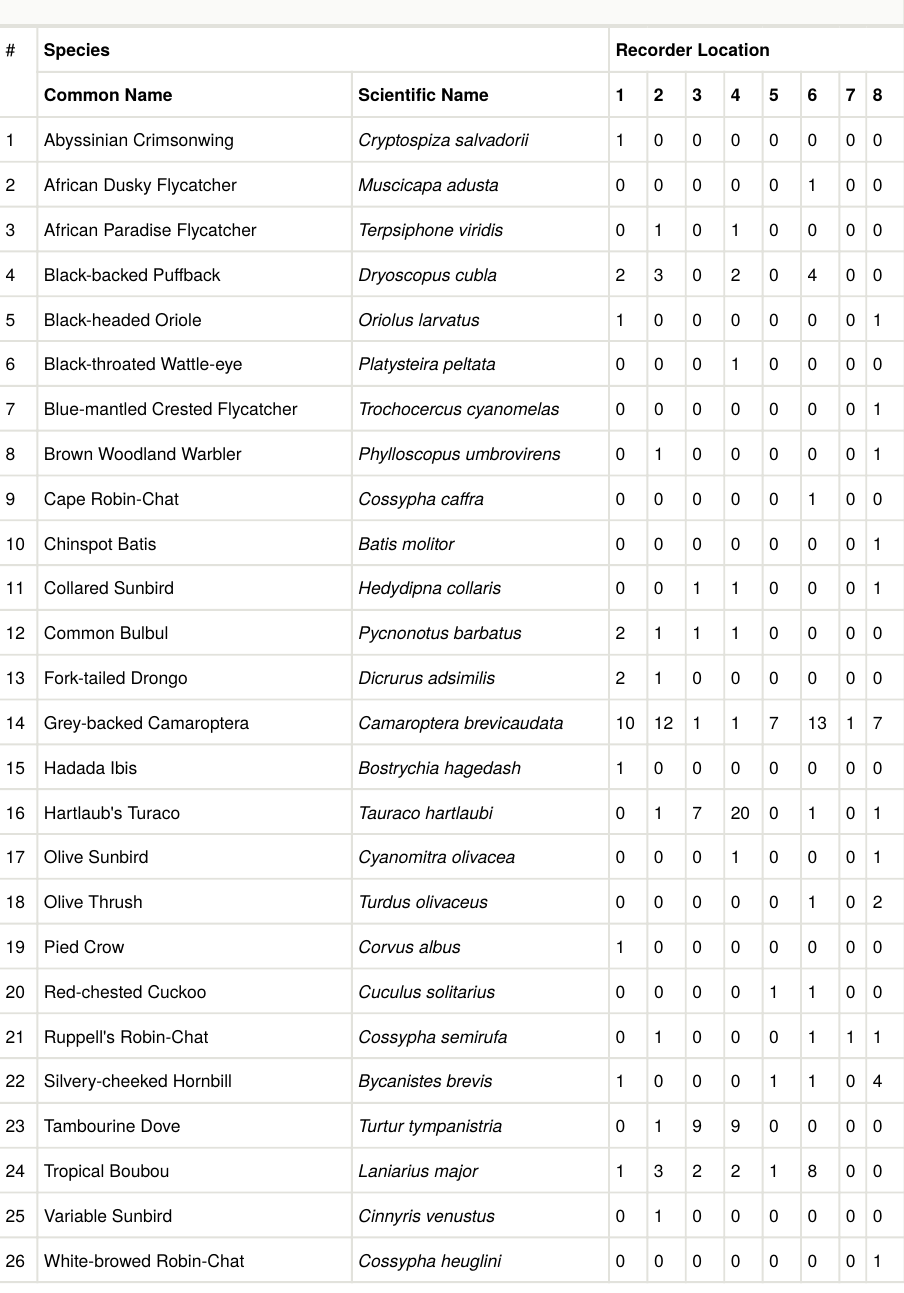
Table 7. Spatial distribution of foreground species. The number of foreground recordings per location for each of the species is